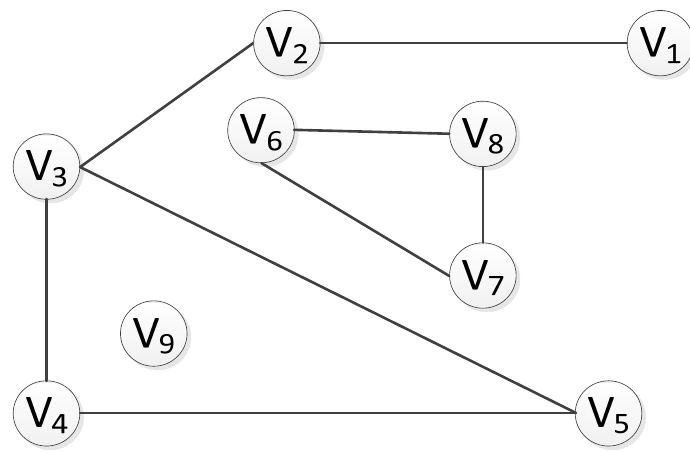
Figure 2. Schematic diagram showing multiple connected subgraphs and independent nodes with loops.